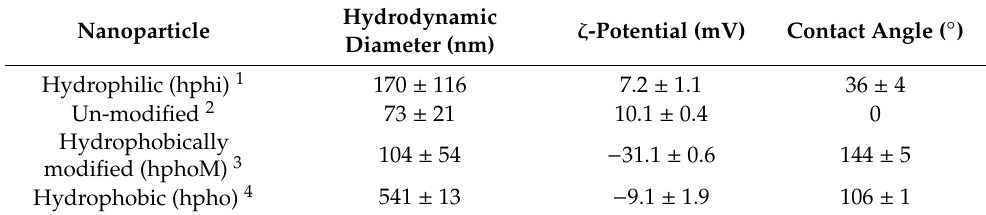
Table 2. Hydrodynamic size and ζ -potential of TiO 2 nanoparticles.